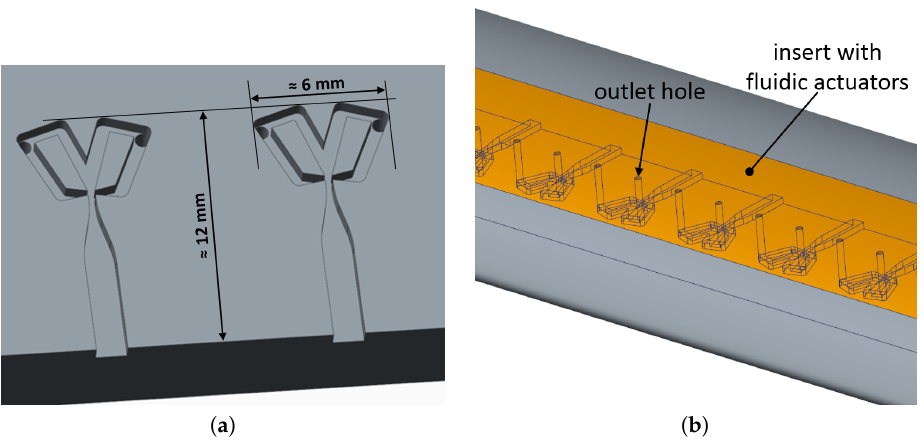
Figure 2. Fluidic oscillators ( a ) geometrical dimensions and ( b ) their integration into the TEC